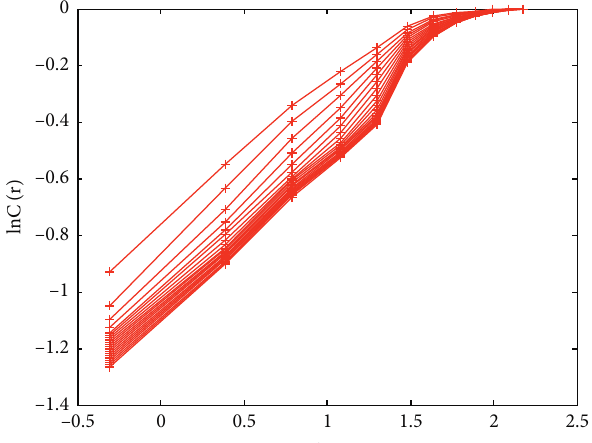
Figure 10: Line graph of correlation dimension of intrinsic mode function (IMF) components.